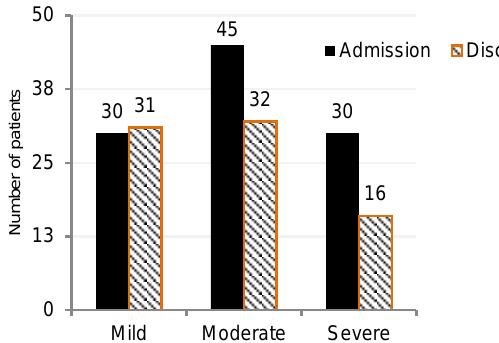
FIGURE 3: Frequency of pain severity ratings at admission and discharge. (N=122